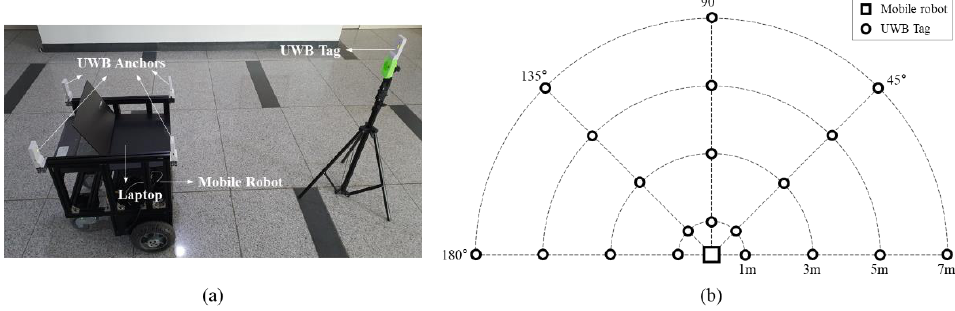
Figure 12. Experimental setup for performance evaluation: ( a ) experimental setup, ( b ) reference positions of the UWB tag.